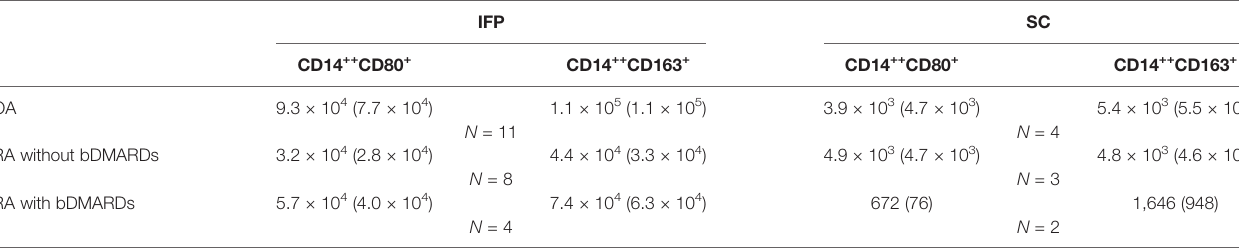
TABLE 2 | CD14 ++ CD80 + cells and CD14 ++ CD163 + cells from the IFP and SC in each disease